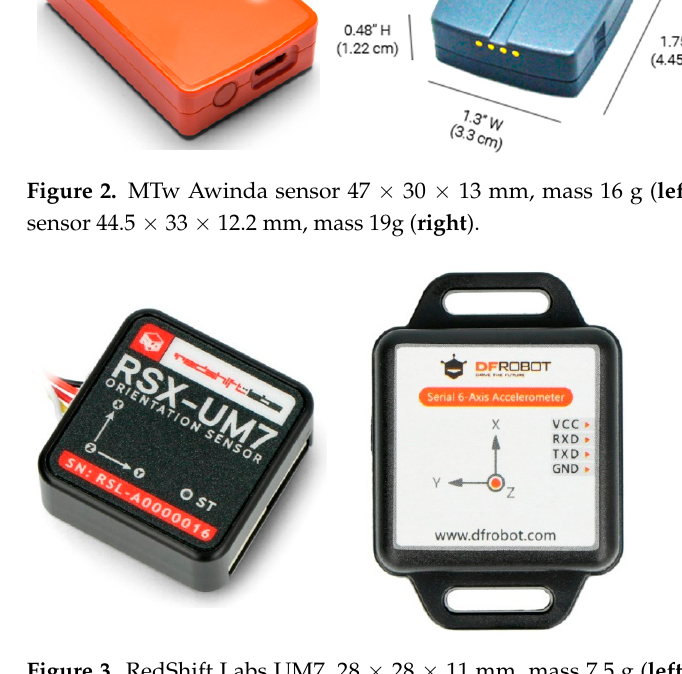
Figure 3. RedShift Labs UM7, 28 × 28 × 11 mm, mass 7.5 g ( left ); and DFRobot SEN0386 sensor, 51.3 × 36 × 10 mm, mass 18g ( right ).